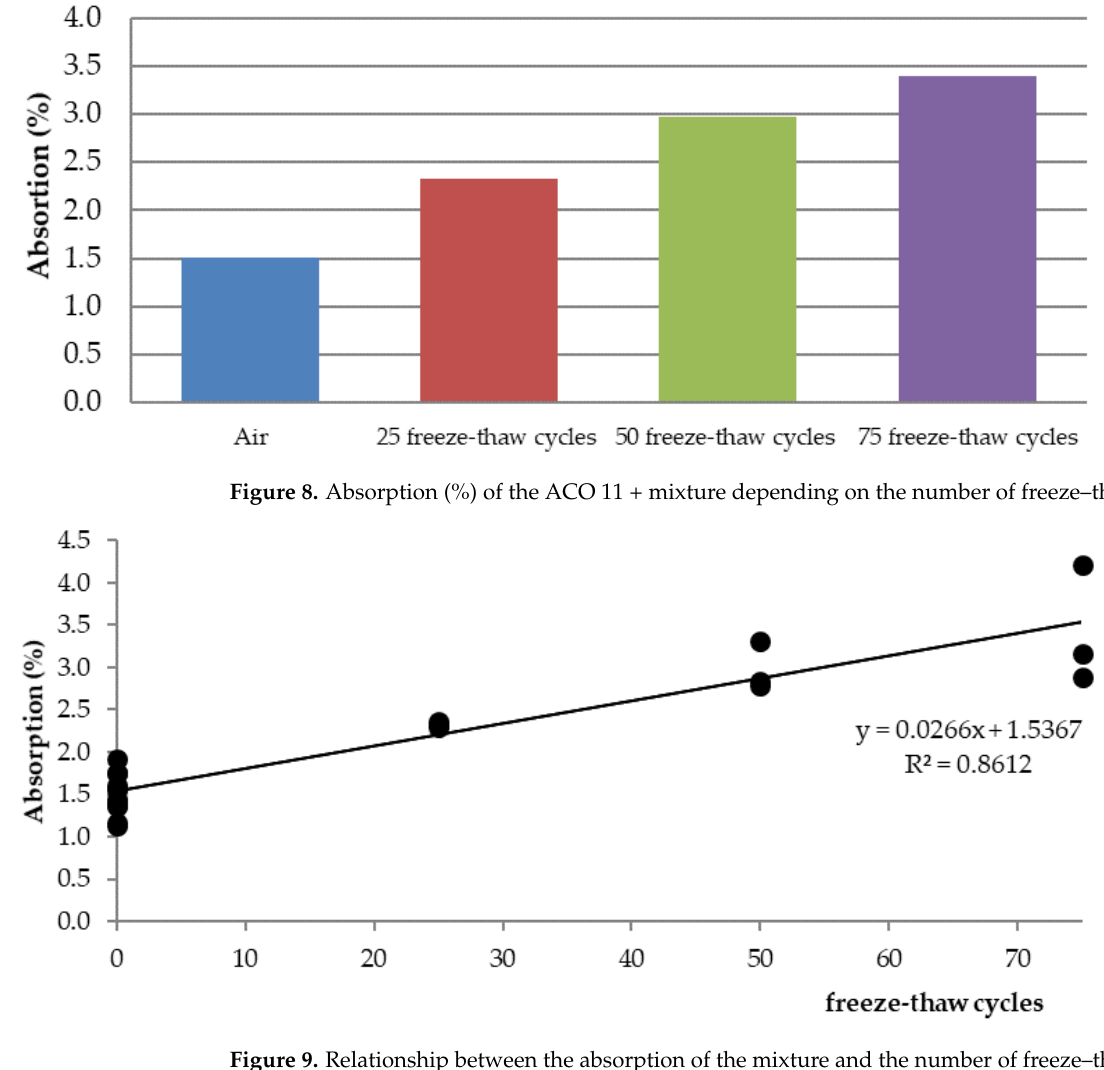
Figure 7. Bulk specific density and air void of the ACO 11 + mixture depending on the number of freeze – thaw cycles.